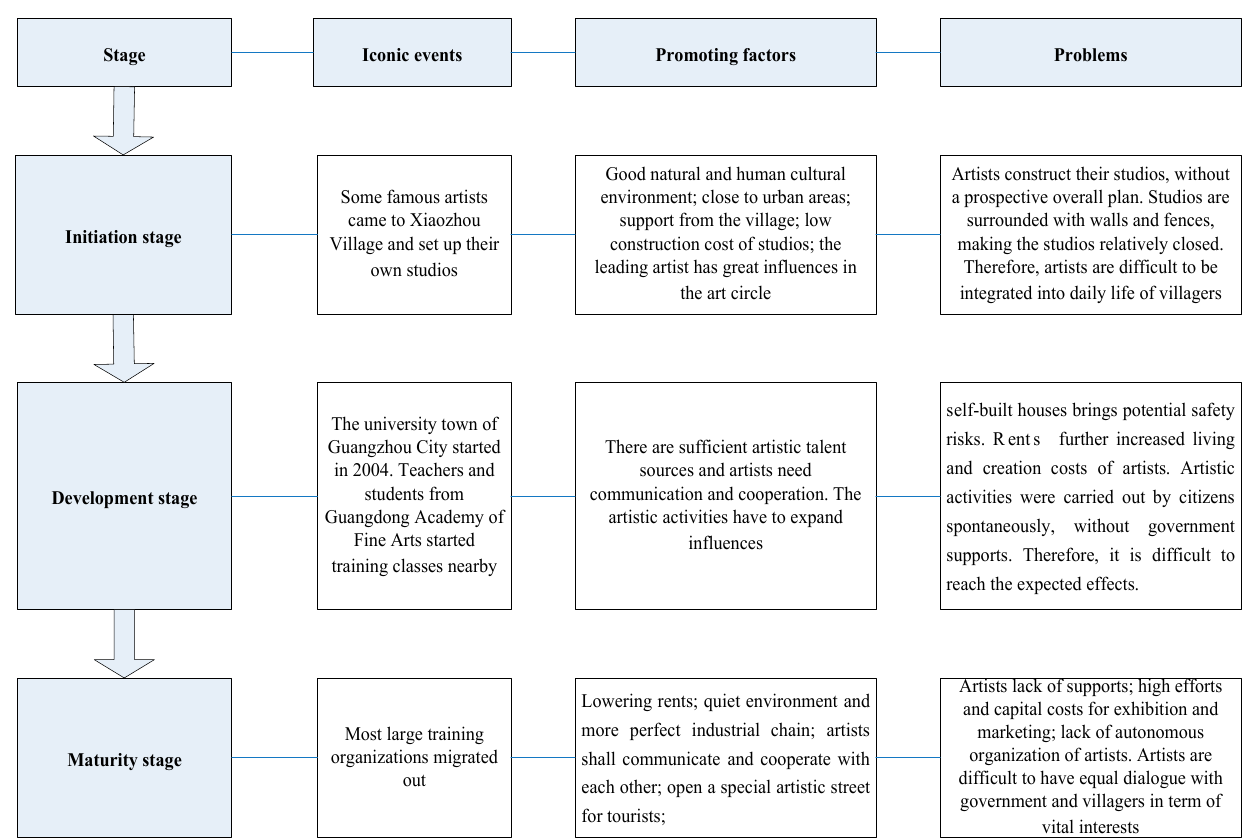
Figure 3. Development path of Guangzhou Xiaozhou Artist Village.